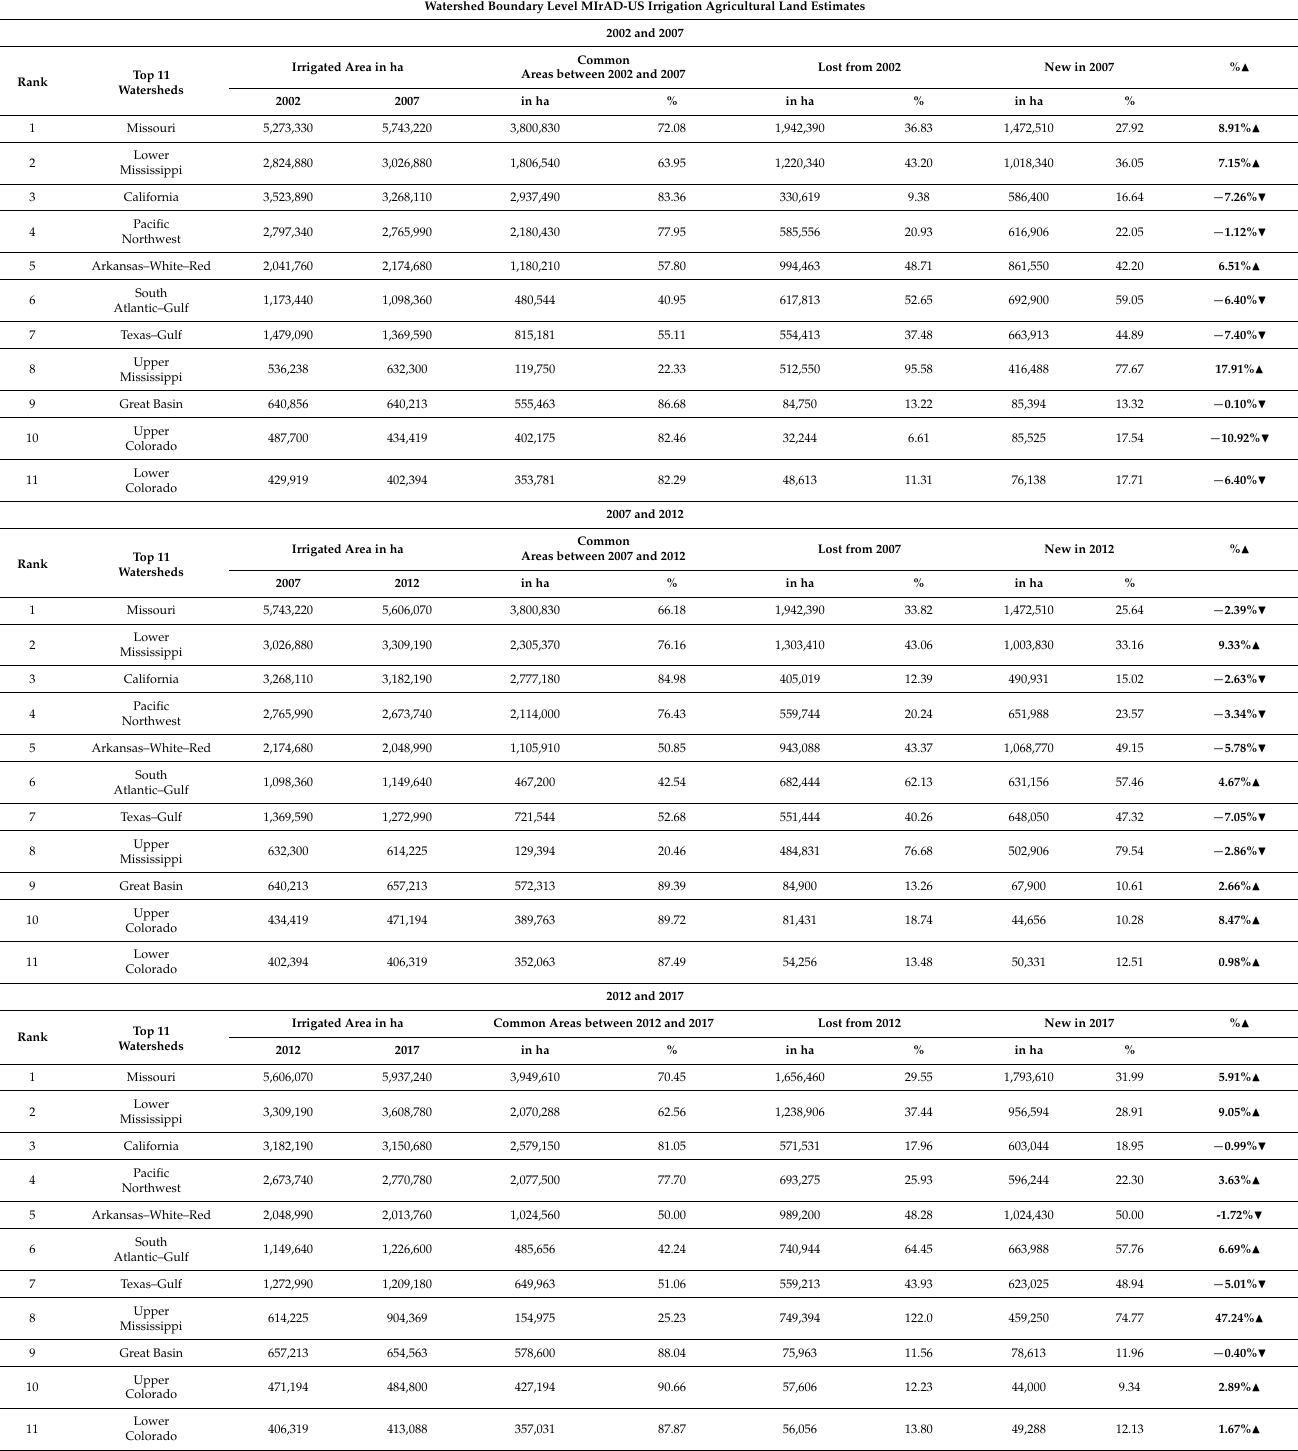
Table 3. Change dynamics in the U.S. irrigated land between 2002 and 2017 at the watershed level. WatershedBoundaryLevelMIrAD-USIrrigationAgriculturalLandEstimates